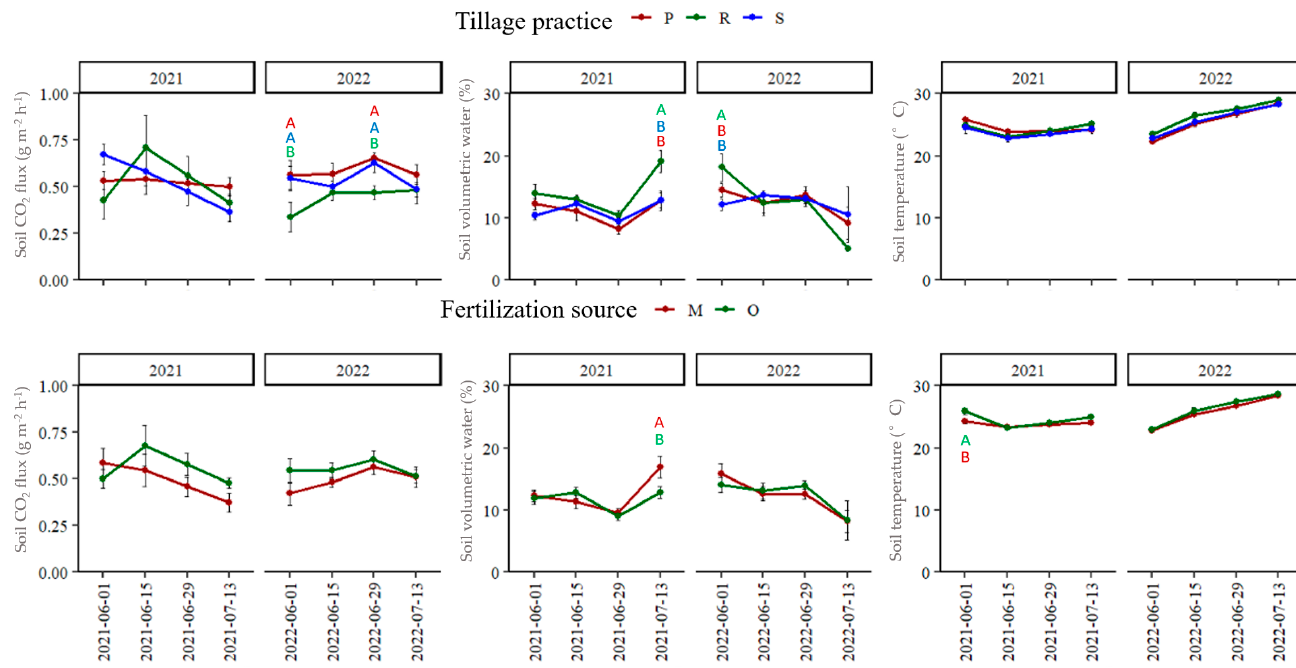
Figure 4. Soil CO 2 emissions, soil temperature, and soil volumetric water content under the three soil tillage practices: plowing (P), subsoil (R), and spading (S), and under inorganic (M), organic (O) fertilization sources during the 2021 and 2022 potato growing seasons. Bars represent standard error. No letters mean that differences between the means were not significant ( p > 0.05).